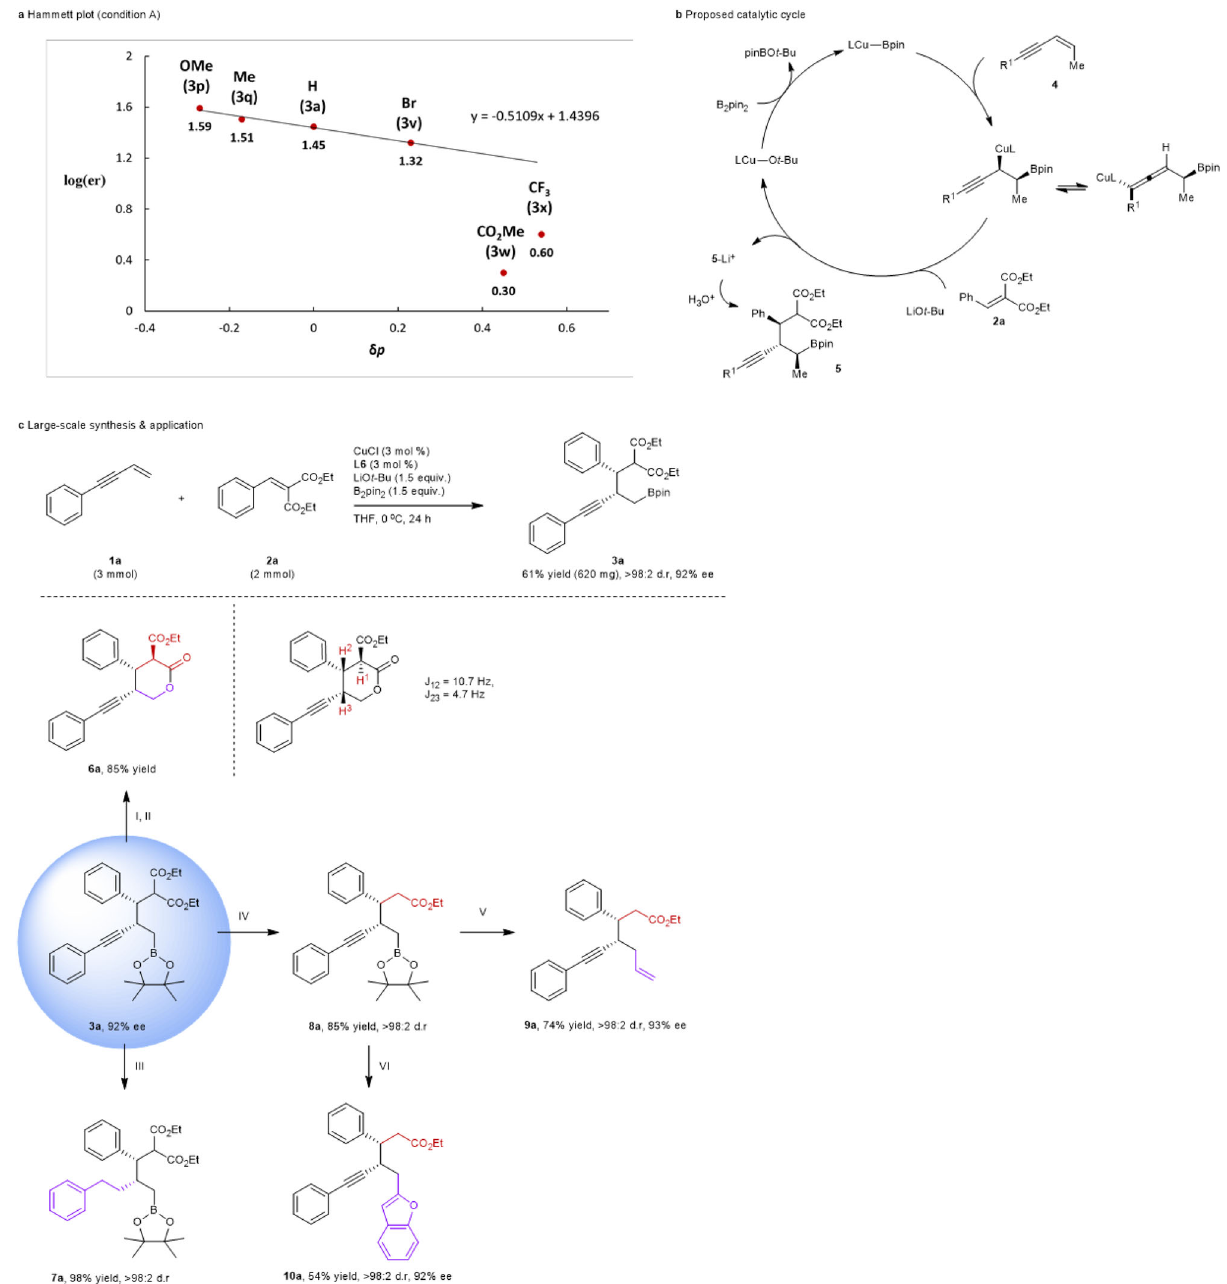
Fig. 5 Mechanistic data and applications. a Hammett plot (condition A). b Proposed catalytic cycle. c Large-scale synthesis & application.